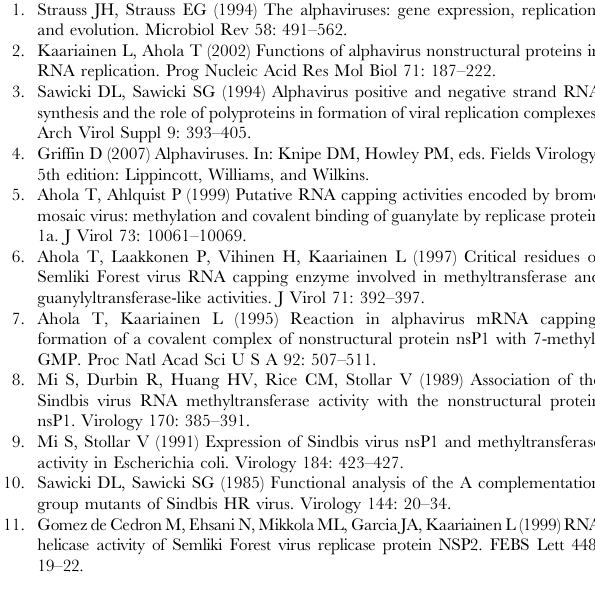
histogram (bottom) from approximately nt 4670 - nt 5220 in nsP3, showing that similar results are obtained using both techniques. Table S1 Oligonucleotides used in this study. PDF) Table S2 Amplicons used in this study. PDF) Table S3 Serum neutralizing titers for individual mice vacci- nated with VEEV ts strains. 80% plaque reduction neutralization titers (PRNT80) of individual animals after inoculation with VEEV ts mutants. Titers registered as , 20 indicate that no neutralization activity was seen at the lowest serum dilution (1:20). Titers registered as . 5120 indicate that plaque numbers were reduced . 80% (compared to a no-serum control) at the highest dilution used in the assay (1:5120). Found at: doi:10.1371/journal.ppat.1001146.s006 (0.03 MB PDF) Data Set S1 Compiled sequencing data. Sequence reads obtained from GS-FLX sequencing were processed as described in the text. Columns F-H indicate the raw number of sequence reads detected at each nucleotide position in the VEEV genome. Columns I-K show the number of insertions per nucleotide position normalized to 100000 reads per